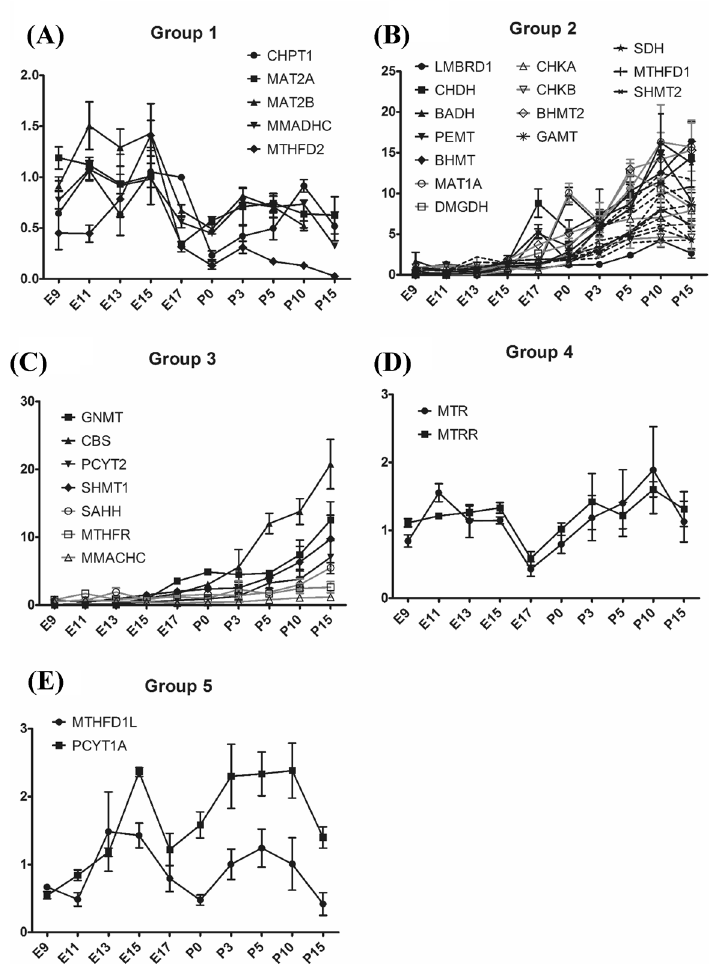
Figure 3. Variation of the expression of 1C metabolism genes in mouse liver ontogenesis. ( A ) Group 1 genes. ( B ) Group 2 genes. ( C ) Group 3 genes. ( D ) Group 4 genes. ( E ) Group 5